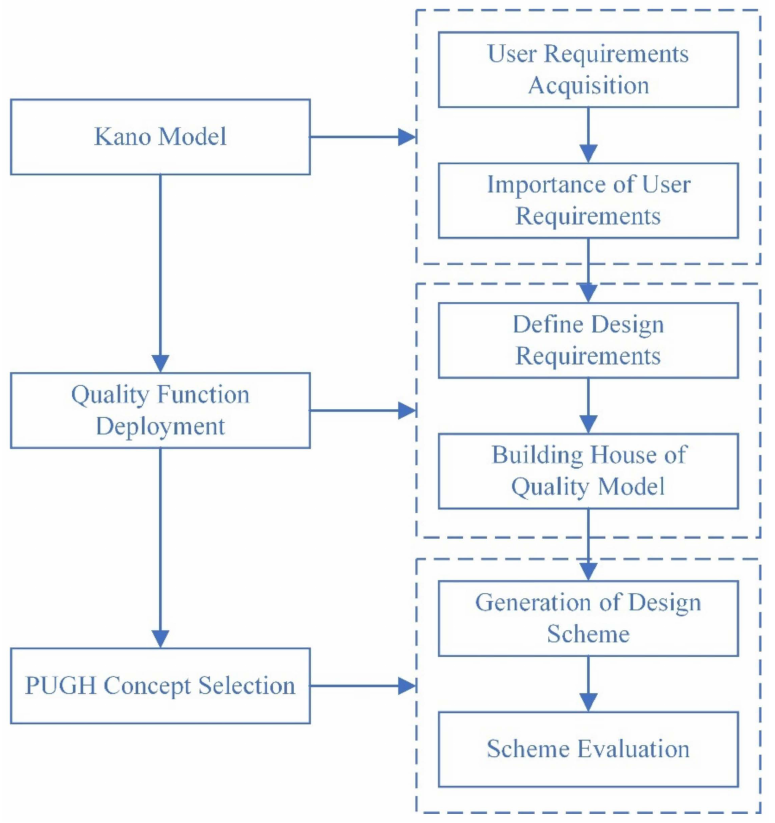
Figure 2. Research method